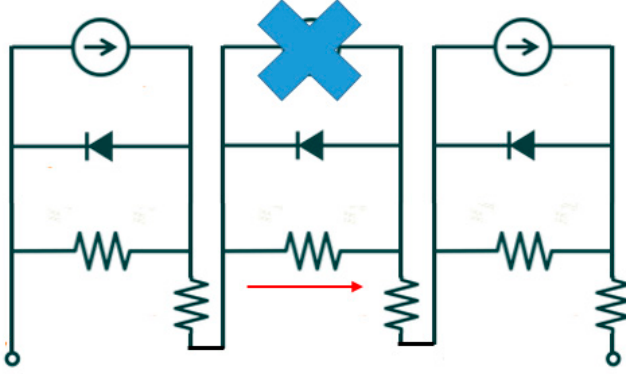
Figure 17. Shadowed cell in a series connection.